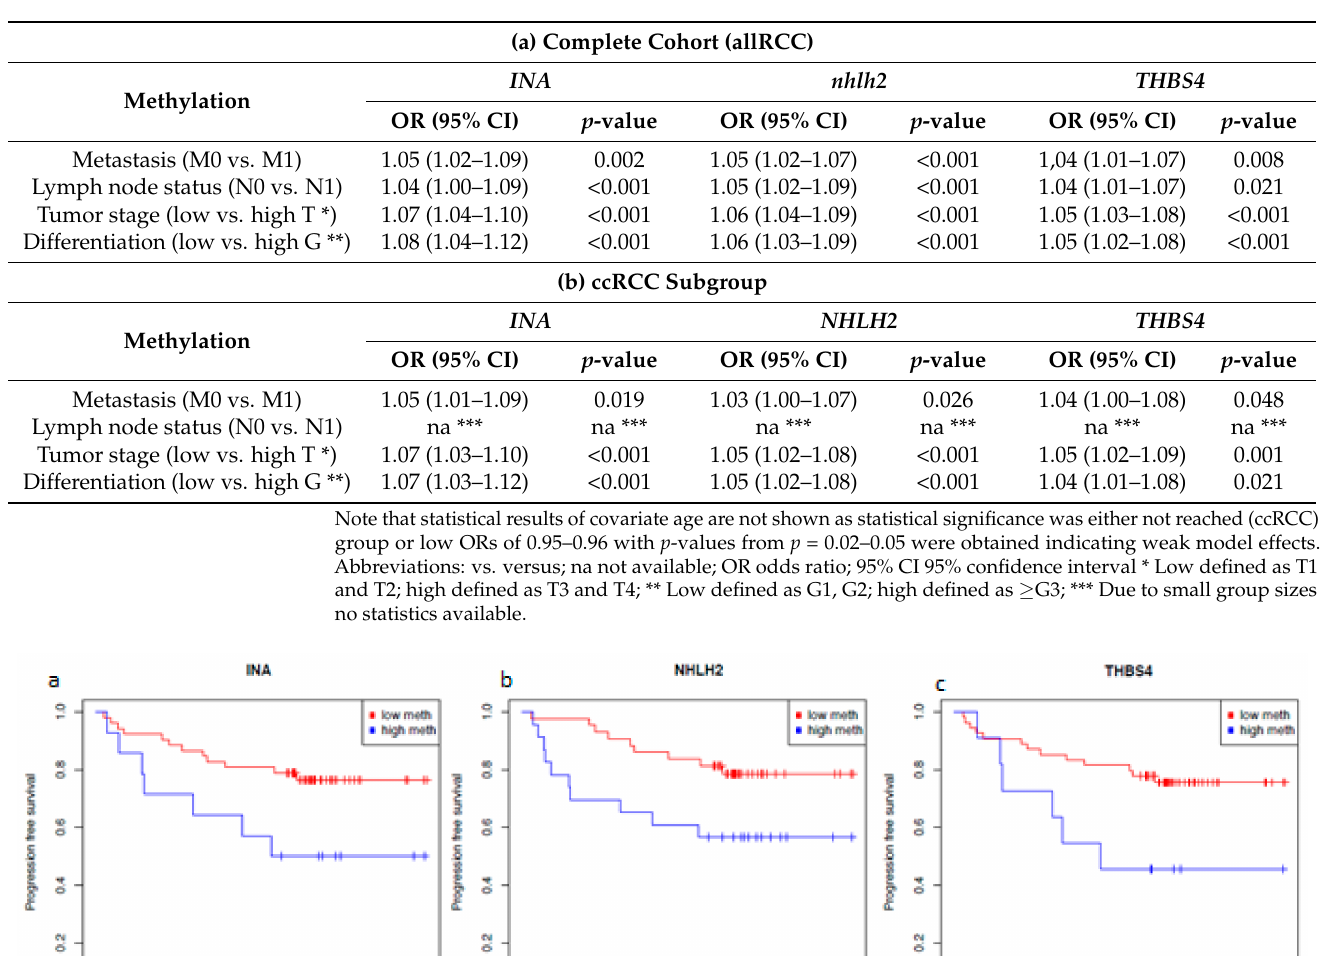
Table 3. Bivariate logistic regression analysis of association of INA, NHLH2, and THBS4 methylation and clinicopathological characteristics.